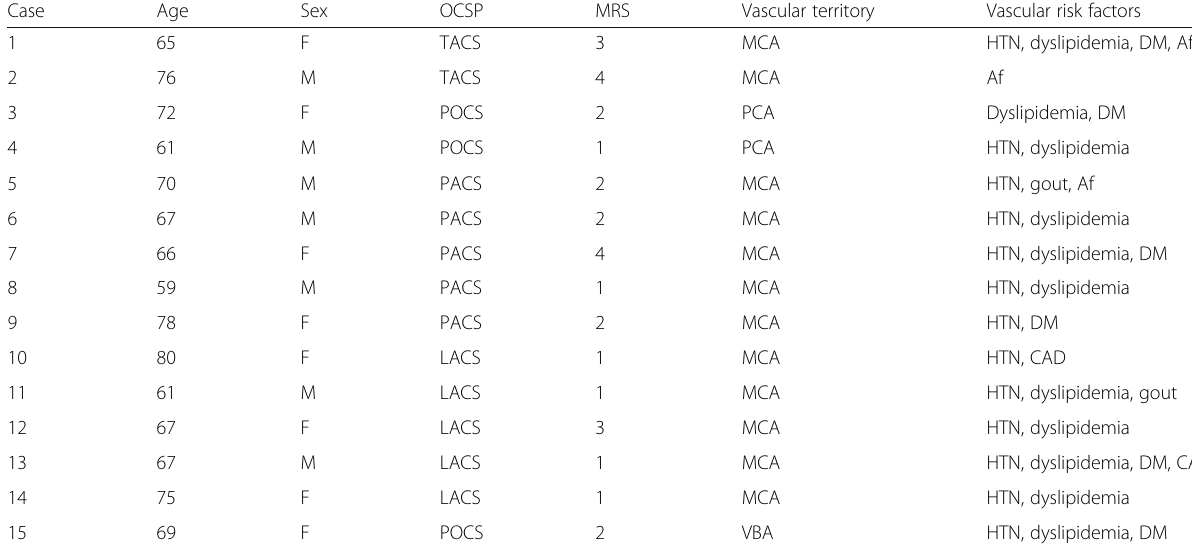
Table 1 The demographic data and stroke clinical patterns for each patient